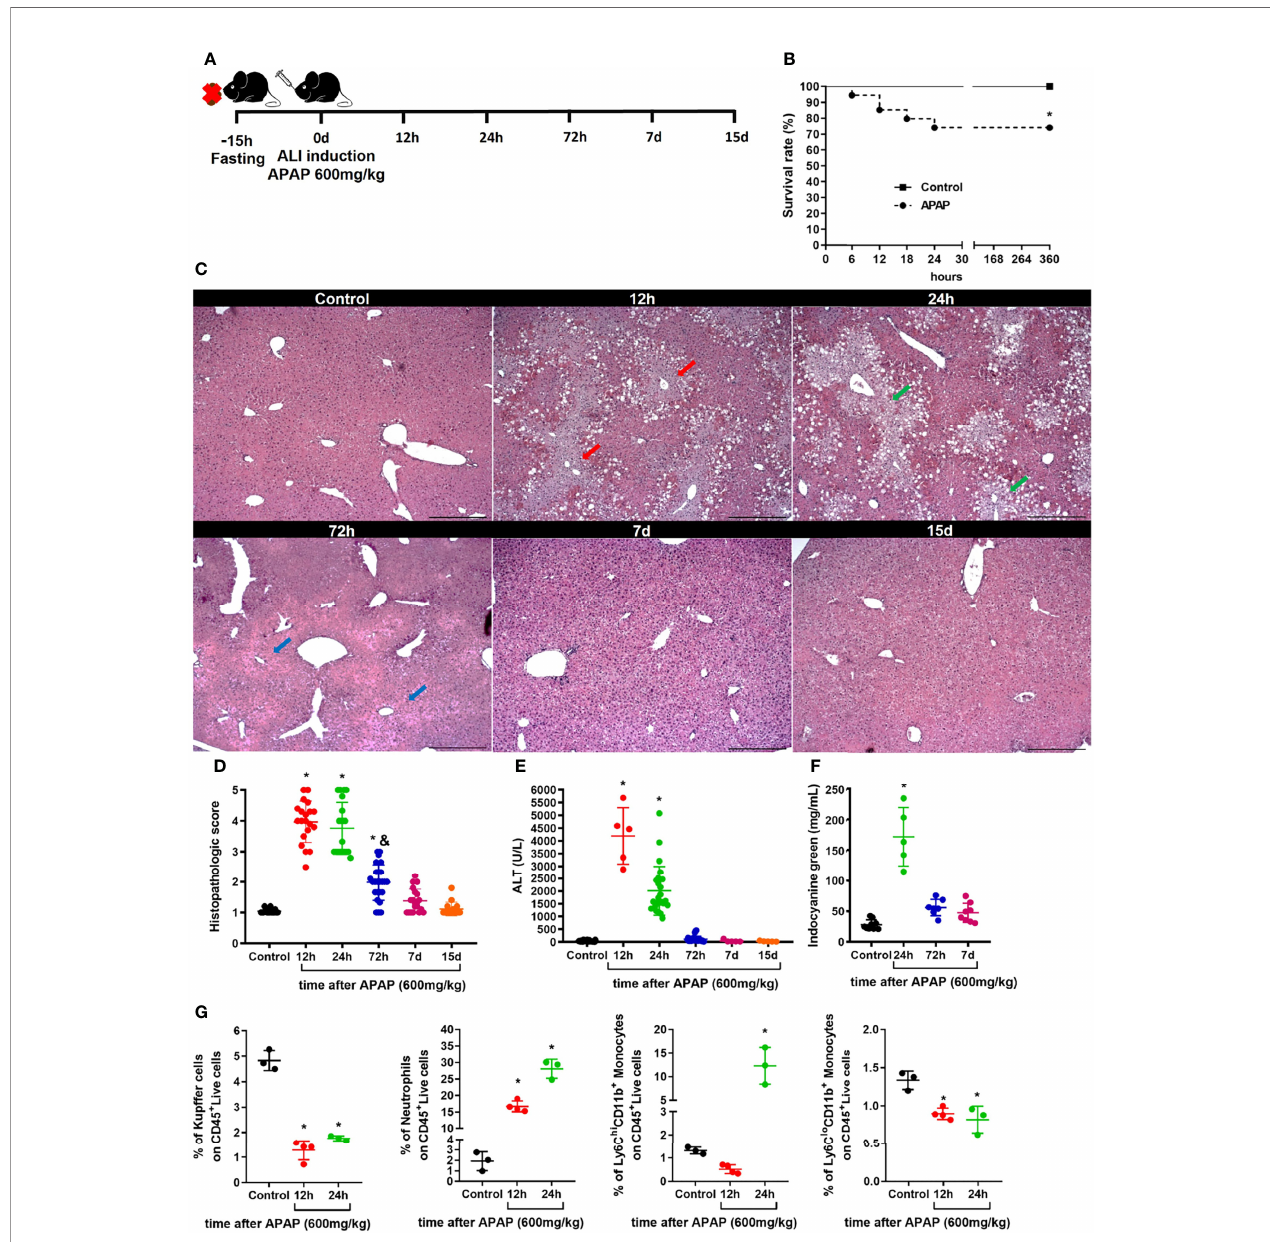
FIGURE 1 | Acute liver injury induced by APAP overdose induces tissue damage and myeloid cell alterations. (A) Scheme for Acute Liver Injury (ALI) induced by Acetaminophen (APAP; 600mg/kg) overdose on 8-10 weeks old C57BL/6J mice. (B) Mice survival rate (%) after ALI induction; n ≥ 9 mice per group. (C) Representative liver histology of ALI kinetics stained with Hematoxylin and Eosin (H&E); scale bar = 500 µm. (D) Time-course of ALI tissue damage measured by the histopathologic score of liver sections; n = 8-15 mice per group. (E) Measurement of liver injury by serum levels of alanine aminotransferase (ALT); n = 5-15 mice per group. (F) Liver dysfunction showed by indocyanine green depuration from the serum; n = 5-9 mice per group. (G) Percentage (%) of different populations of myeloid cells within the CD45 + live cell pool during acute liver in fl ammation obtained by fl ow cytometry; n = 3-5 mice per group; Representative of 3 independent experiments. Data are presented as mean ± SEM. * indicates statistical difference to the control group using Mantel-Cox survival test (B) and one-way ANOVA followed and Tukey post-test (D-G) (* = p < 0.05). & indicates statistical difference compared to the 24h group using one-way ANOVA followed and Tukey post-test (& = p < KC morphology did not fi nd a signi fi cant difference in KCs ALI. At steady-state, the liver parenchyma (blue, area (Supplementary Figure 2B) , length (Supplementary auto fl uorescence to 405nm laser) and the vasculature (white) Figure 2C ), elongation ( Supplementary Figure 2D ), and was healthy with F4/80 + KCs (red) located inside the circularity ( Supplementary Figure 2D ) during the course of vasculature with projections to parenchyma (Figure 2A and